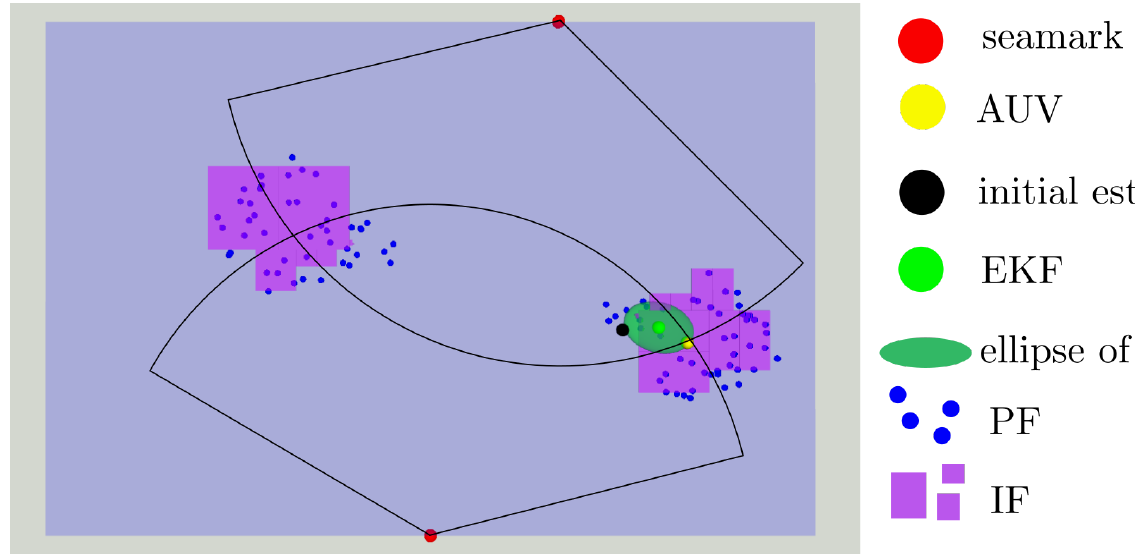
Figure 1. Top view of the localization in the static